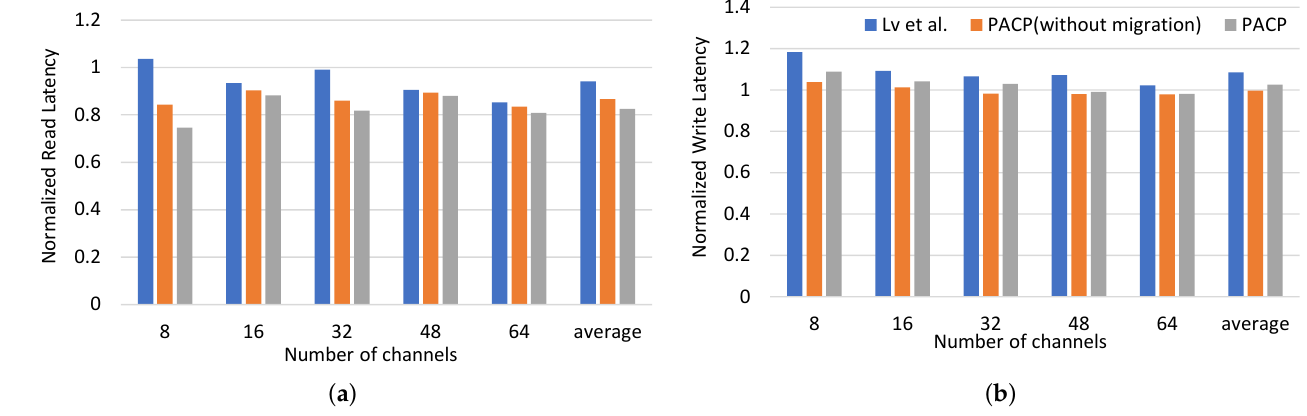
Fig. 8. Read Latency latency comparison under different interference condition (a) high- interference workload (hm_1); (b) low-interference workload (web_0); and workload (b)